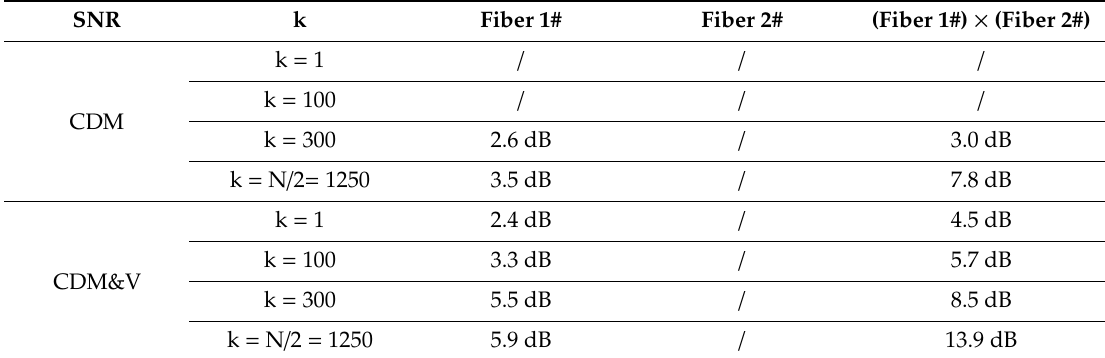
Table 1. SNR comparison between the CDM and CDM&V. No SNR value in Fiber 2# due to signal fading. The SNR is defined as a ratio between the peak power at the vibration position and that at the strongest side-peak not belonging to the main lobe.